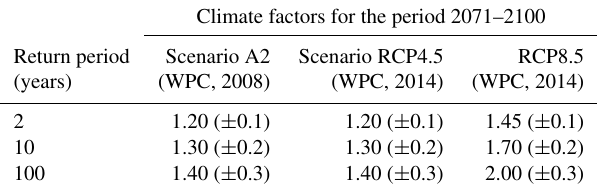
Table 2. Recommended climate factors for design of drainage sys- tems in Denmark according to WPC (2008, 2014) and Gregersen et al. (2014b). The climate factors are valid for a duration of 1h but also recommended for other durations up to 3h. The indices marked with bold are the ones used in this paper. The standard deviations are not provided directly in the references, but estimated from tables and